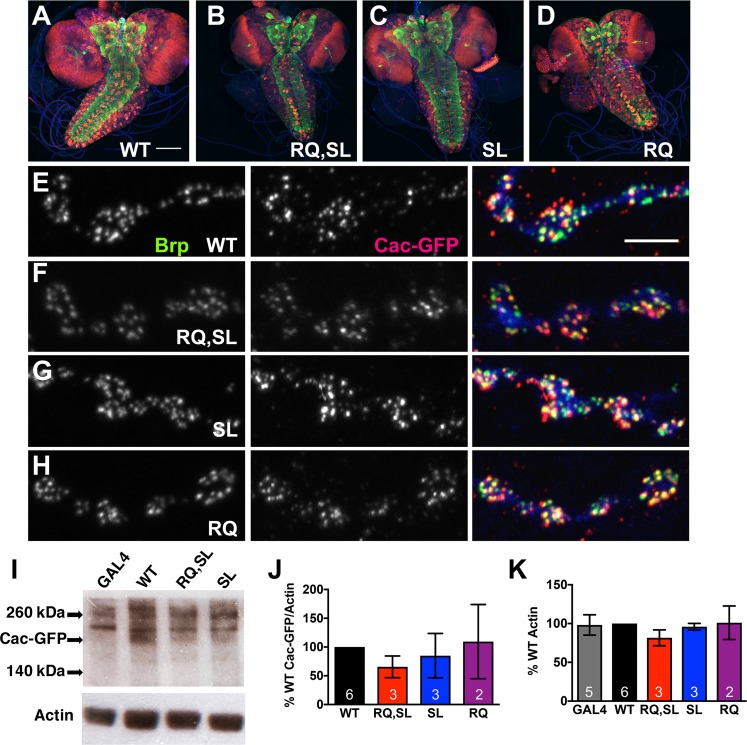
Localization and expression levels of Cac-GFP transgenes are normal.(A-D) Images of larval central nervous systems from animals expressing Cac-GFP protein (WT or mutant). Anti-GFP (red), and anti-Bruchpilot (Brp—green) staining are shown. Scale bar 100 μm. (E-H) Wild-type and mutant Cac-GFP successfully localized to NMJ active zones, as indicated by co-staining with anti-Brp (green) and anti-GFP (red). Scale bar 5 μm. (I) Western blots of fruit fly head lysates (10 heads/lane, single sex per Western), from flies expressing either elaV-Gal4 alone or the indicated UAS-cac-eGFP transgene driven by elaV-Gal4. Blots were probed with anti-GFP (top) and anti-Actin (bottom) antibodies. The band corresponding to Cac-GFP is indicated. Other bands are non-specific. (J) Compared to WT, there was no statistically significant change in Cac-GFP expression for any of the transgenic lines utilized in this study (band normalized to actin; p > 0.65, one-way ANOVA with Dunnett’s multiple comparisons vs. WT; GAL4 alone control excluded from analysis). (K) Actin levels were also steady across all transgenic lines (p > 0.71, one-way ANOVA with Dunnett’s multiple comparisons vs. WT).